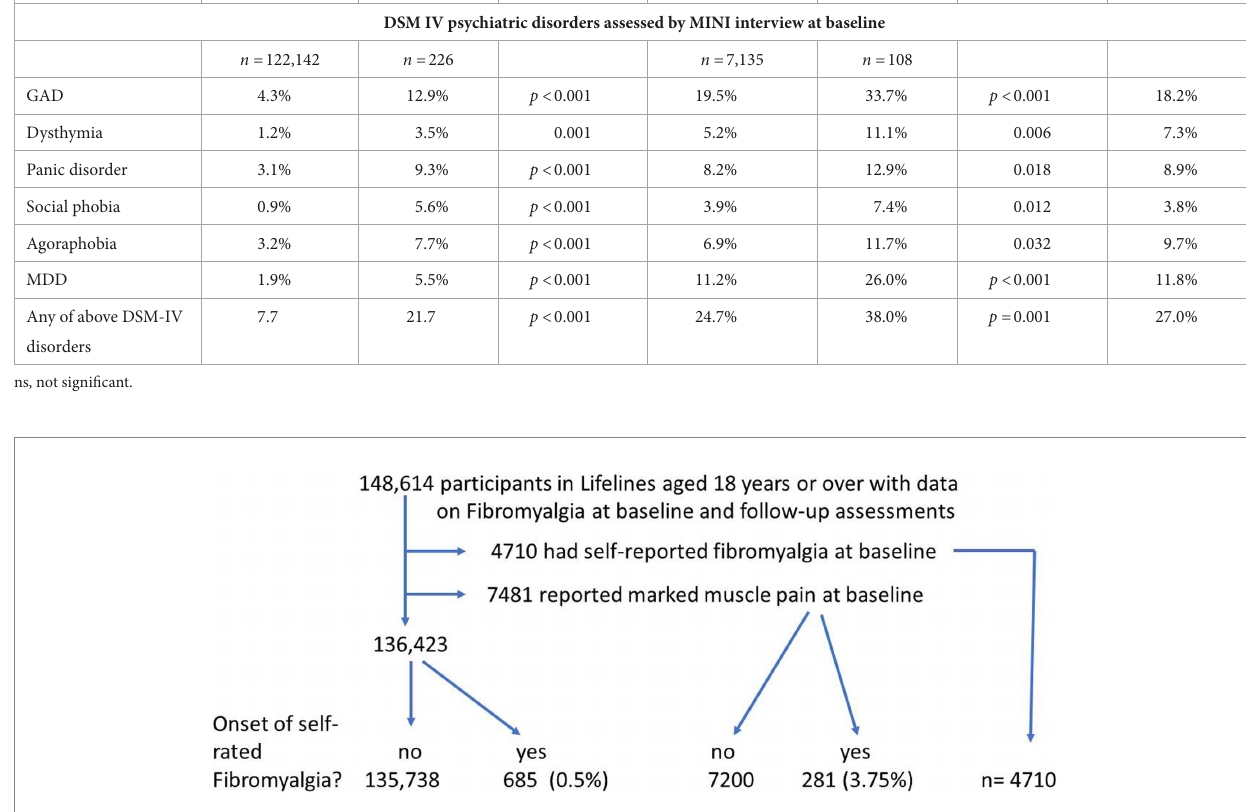
FIGURE 1 Flowchart of